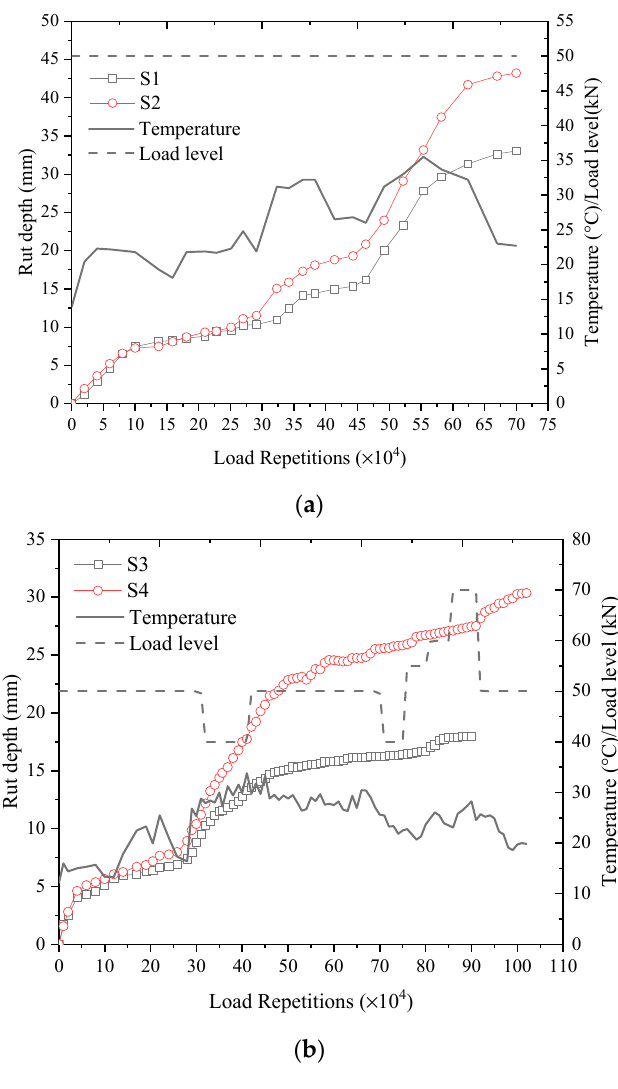
Figure 7. The rut progression history and corresponding test conditions of the four test sections: ( a ) rut progression history of test sections S1 and S2; ( b ) rut progression history of test sections S3 and S4.